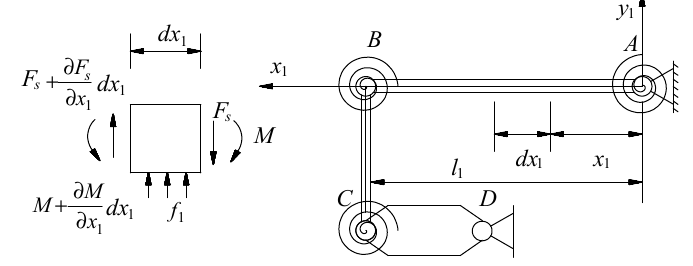
Figure 6. Free vibration model of driving beam.